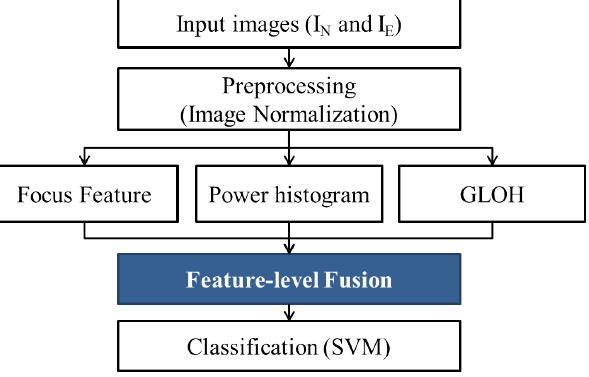
Figure 18. Flowchart of the feature-level fusion